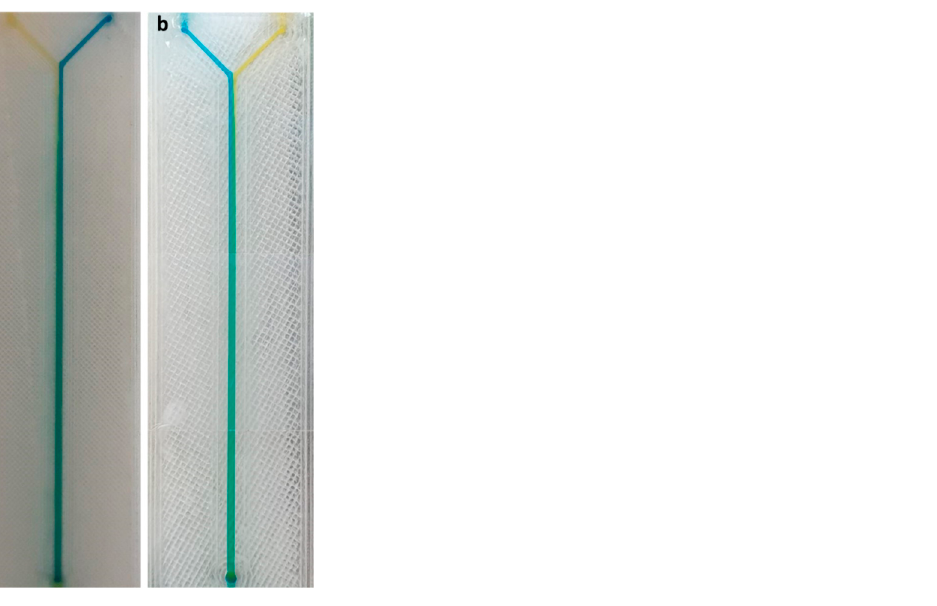
Figure 7. Full top view of 3D printed microfluidic devices, demonstrating transparency: ( a ) translu- cent PLA; ( b ) transparent PLA.